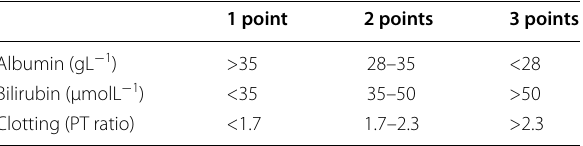
Lactate (mmol L − 1 ) added to the total points score from above